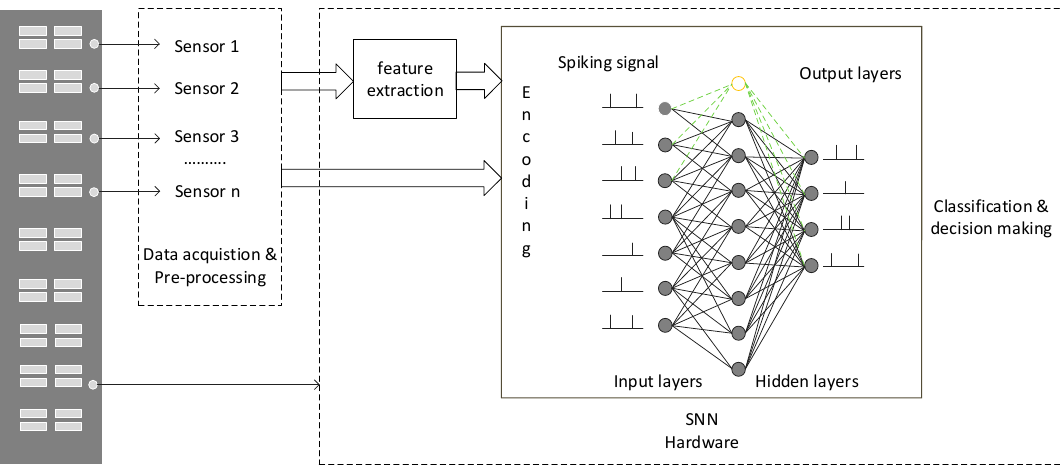
Figure 1. A Spiking Neural Network (SNN)-based Structural Health Monitoring (SHM) system.